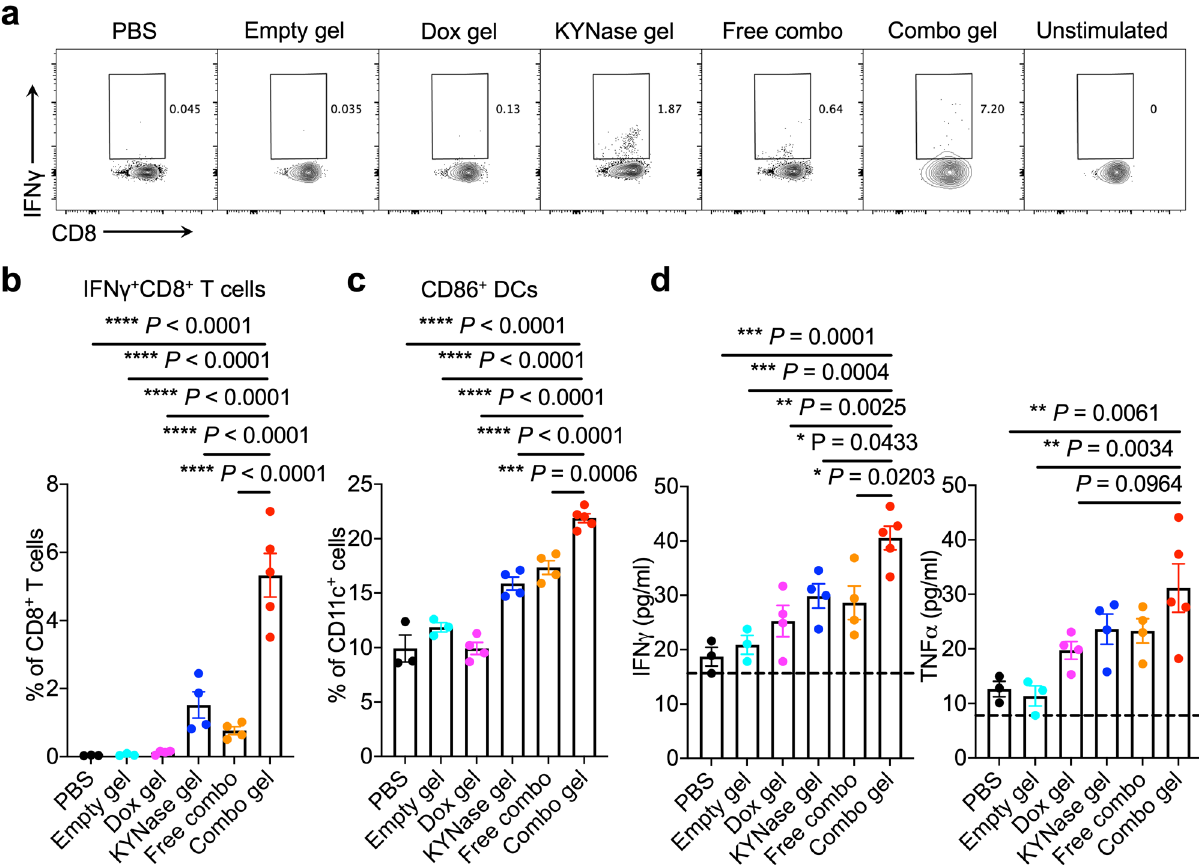
Fig. 4 The combo gel treatment boosts tumor-speci fi c T cell responses in TdLNs and systemic in fl ammatory cytokine release. Following 4T1 tumor inoculation on day 0, different treatments were administered on day 10 when tumor volumes reached 100 mm 3 . TdLNs were analyzed 4 days after treatment. n = 3 mice for PBS and empty hydrogel groups, n = 5 mice for the combination hydrogel group, and n = 4 mice for the other groups. a , b Representative FACS plots ( a ) and percentage ( b ) of IFN γ + CD8 + T cells in TdLNs after restimulation with 4T1 tumor cells. c Quanti fi cation of CD86 + DCs in TdLNs. d Serum IFN γ and TNF α levels 3 days after treatment. The detection limit was annotated with the black line. Data are represented as mean ± s.e.m., and one-way ANOVA with Turkey ’ s post hoc test was used. Source data are provided as a Source Data fi